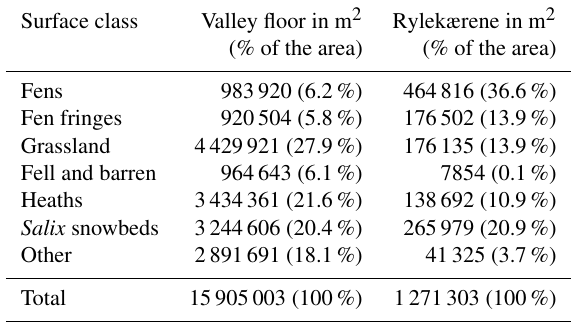
Table 1. Absolute and relative area distributions for the six main surface cover classes in the two study areas shown in Fig. 1, updated to the Zackenberg River extent in 2014. The “fen fringe” surface class covers the outer 10m of the fen